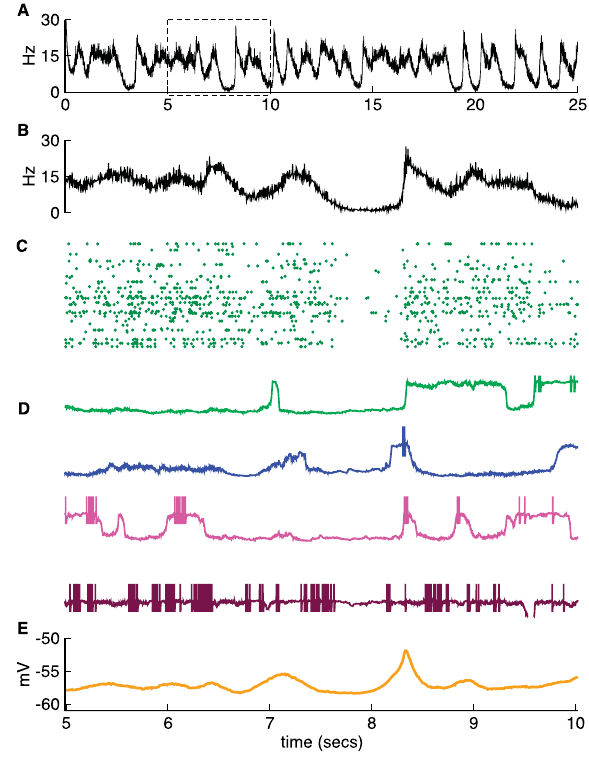
Figure5. AmoreirregularnetworkI .Theinhibitoryconductanceofthenoise model was decreased by 15% with respect to that of the regular network in Figures 2 and 3 . The traces are shown with the same convention as in Figure 2 , and the four neurons in D are the same as those in Figure 2D. The expanded box and panels B–E show the interval between 5 and 10seconds during the simulation. A synchonous transition occurs after t=8seconds.